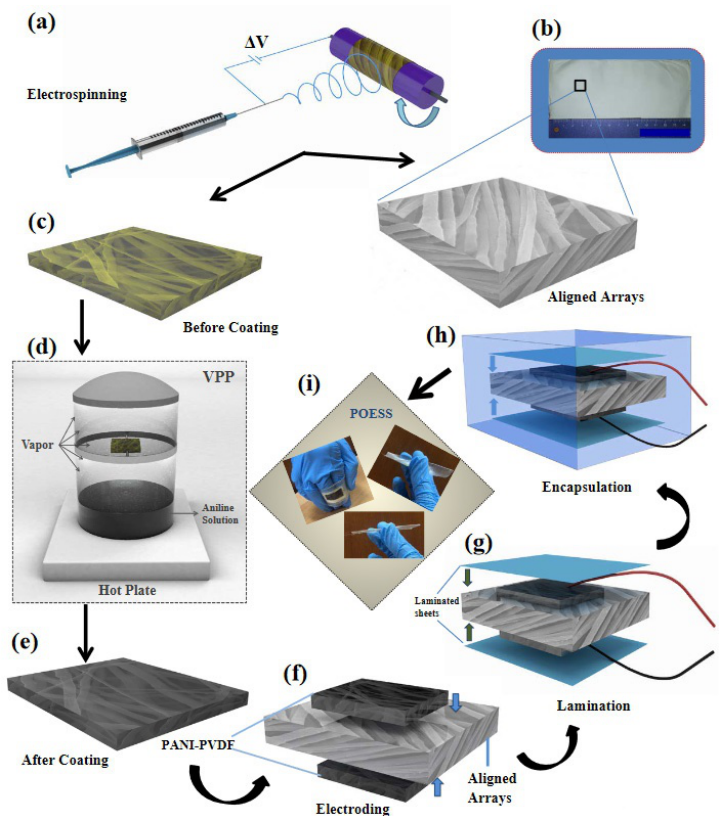
Figure 1. ( a ) electrospinning process, ( b ) photograph of the large-scale prepared mat of highly aligned PVDF NFs arrays; enlarged view exhibits the structure from respective section, ( c ) structure